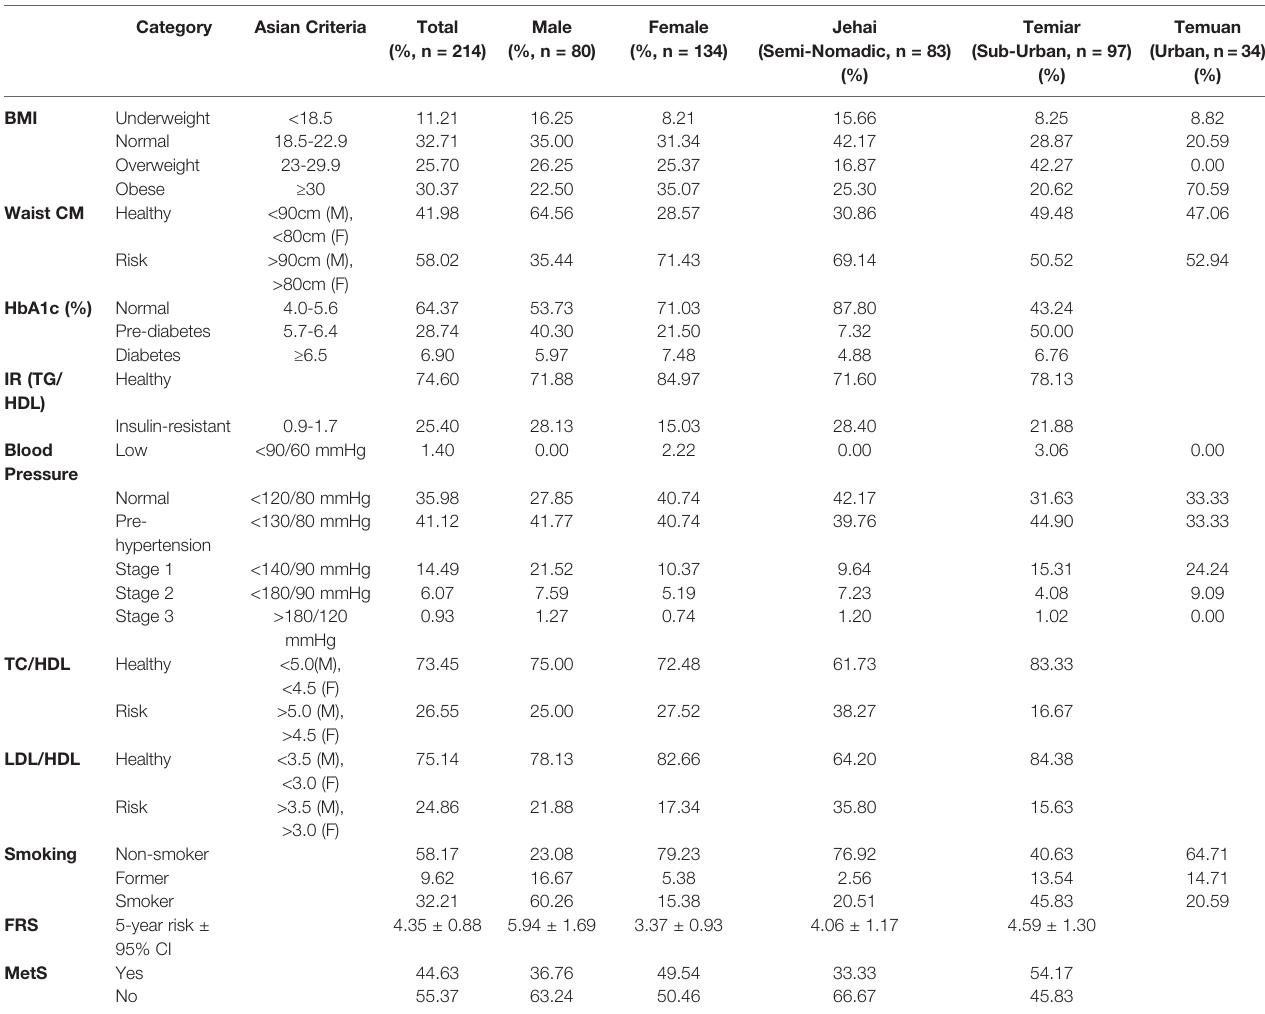
TABLE 1 | Anthropometrics and cardiometabolic health measures of OA. Category Asian Criteria